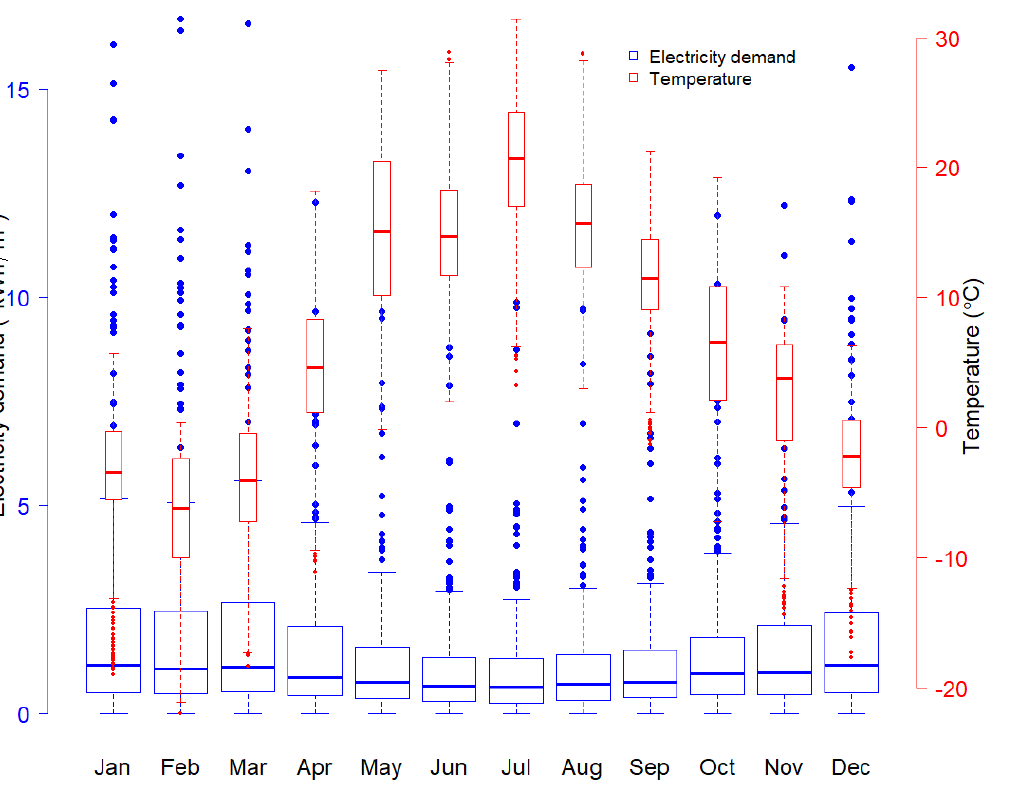
Figure 8. Monthly electricity demand and air temperature in Borlänge in 2018.